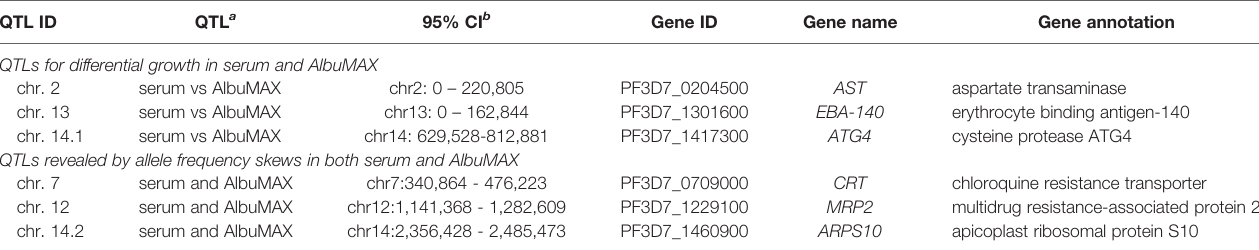
TABLE 1 | Top candidate genes located inside of the QTL regions.